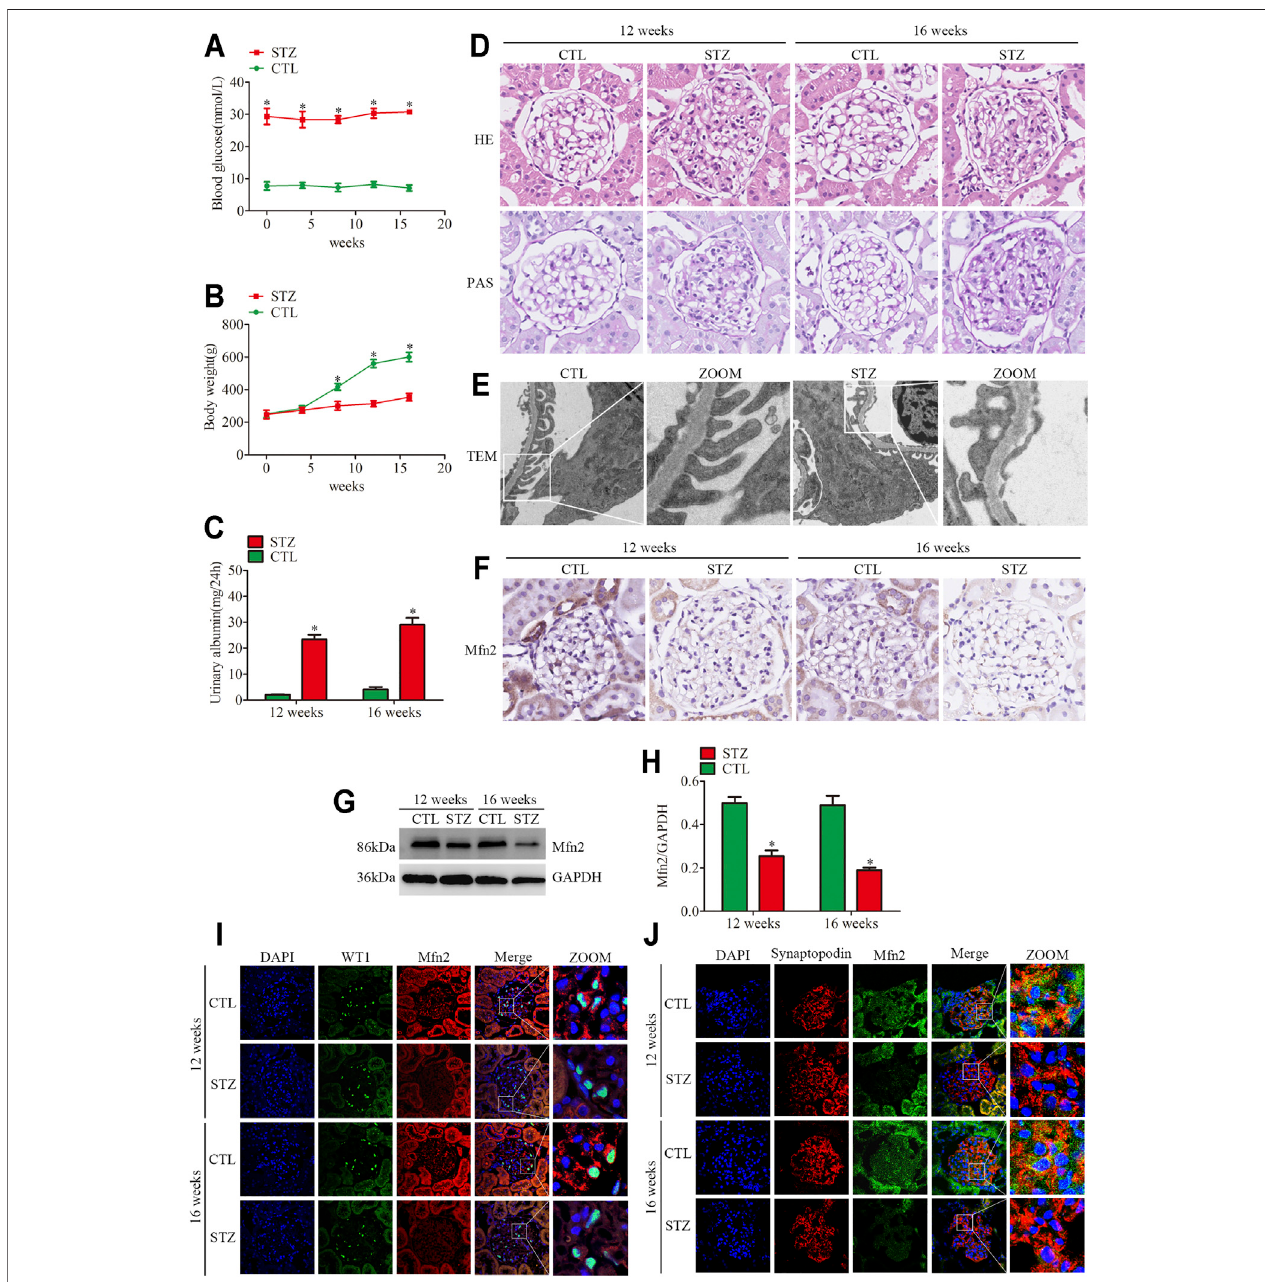
FIGURE1| HistopathologicalchangesandMfn2expressionindiabeticrats. (A) Bloodglucoselevelspergroup(n (cid:1) 3).* p < 0.05relativetocontrolatthesametime point. (B) Bodyweight per group (n (cid:1) 3). * p < 0.05 relative to control at the same time point. (C) Quantitative analysis of 24 h urine total proteins (UTP) of rats at 12 or 16 weeks post-STZ injection (n (cid:1) 3). * p < 0.05 relative to control at the same time point. (D) Histological changes in rats after STZ injection were determined by HE and PAS staining (original magni fi cation, × 600). (E) The TEM images of the glomerular ultrastructure of rats at 16 weeks post-STZ injection (original magni fi cation, × 3,000). (F) RepresentativeimagesofimmunohistochemicalstainingofMfn2inglomerulipergroup(originalmagni fi cation, × 600). (G,H) RepresentativeWesternblotsof glomerular Mfn2 expression and quantitation per group (n (cid:1) 3). * p < 0.05 relative to control. (I,J) Representative images of immuno fl uorescent staining of Mfn2, WT1 or Synaptopodin and DAPI in glomeruli per group (original magni fi cation, × 600). CTL, control; STZ, streptozotocin; HE, Hematoxylin and Eosin; PAS, Periodic acid-Schiff; TEM, transmission electron microscope; Mfn2, Mitofusin2.